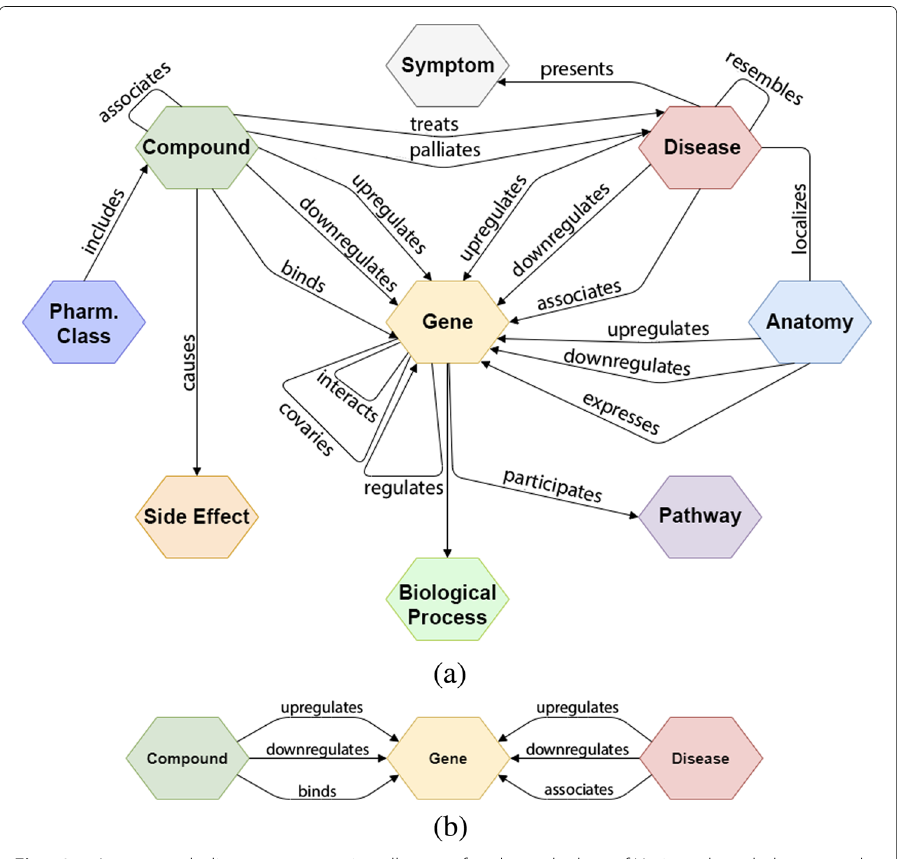
Fig. 12 a A metagraph diagram representing all types of nodes and edges of Hetionet knowledge network. b The metagraph diagram of the case study network extracted from Hetionet